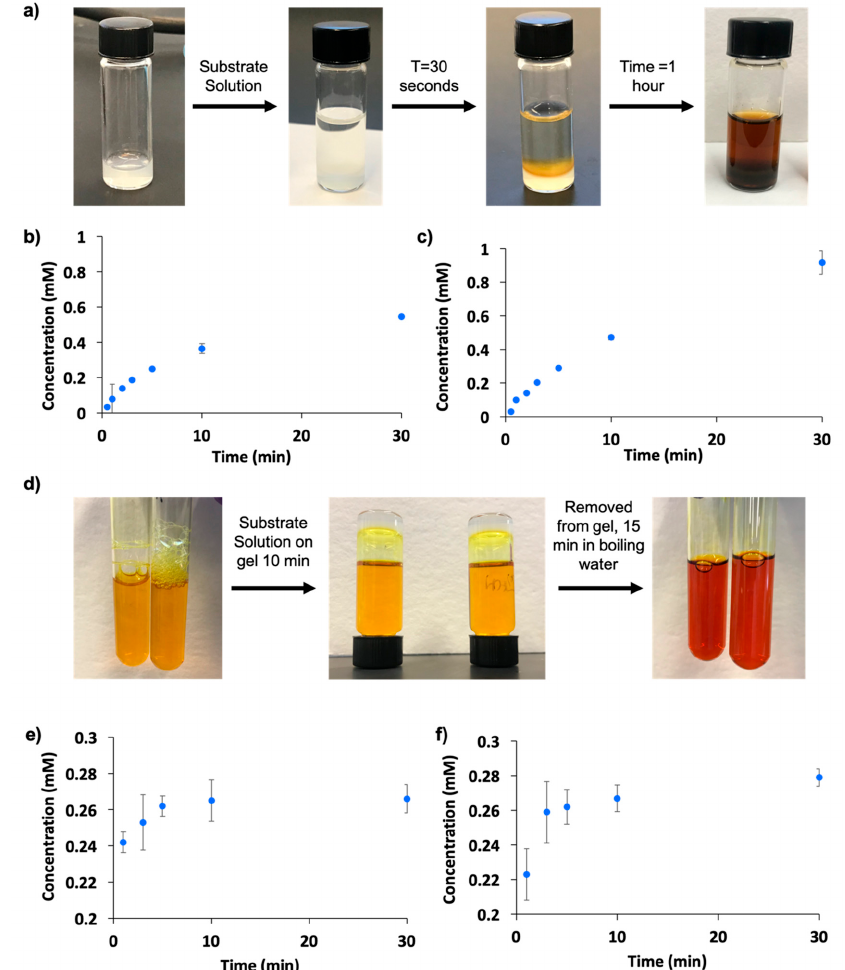
Figure 5. ( a ) Image of the amino acid hydrogels with HRP entrapped prior to substrate solution addition on top and after three minutes. ( b ) Quantification data of product formation using MA- l -Phe-OH entrapped hydrogel over time using absorbance at 420 nm and the known extinction coe ffi cient of 2640 cm − 1 M − 1 . ( c ) Quantification data of product formation using MA- d -Phe-OH entrapped hydrogel over time using absorbance at 420 nm and the known extinction coe ffi cient of 2640 cm − 1 M − 1 . ( d ) Image of the amylase-entrapped amino acid with the substrate solution shown prior to addition on top of hydrogel and after 10 min on top of the hydrogel and 15 min. in boiling water. When in contact of a reducing sugar, the color reagent containing dinitrosalicylic acid goes from a yellow-orange color to a darker orange-red color. ( e ) Quantification data of product formation using MA- l -Phe-OH entrapped hydrogel over time using absorbance at 540 nm and the calculated extinction coe ffi cient of 1340.6 cm − 1 M − 1 . ( f ) Quantification data of product formation using MA- d -Phe-OH entrapped hydrogel overtime using absorbance at 540 nm and the calculated extinction coe ffi cient of 1340.6 cm − 1 M − 1